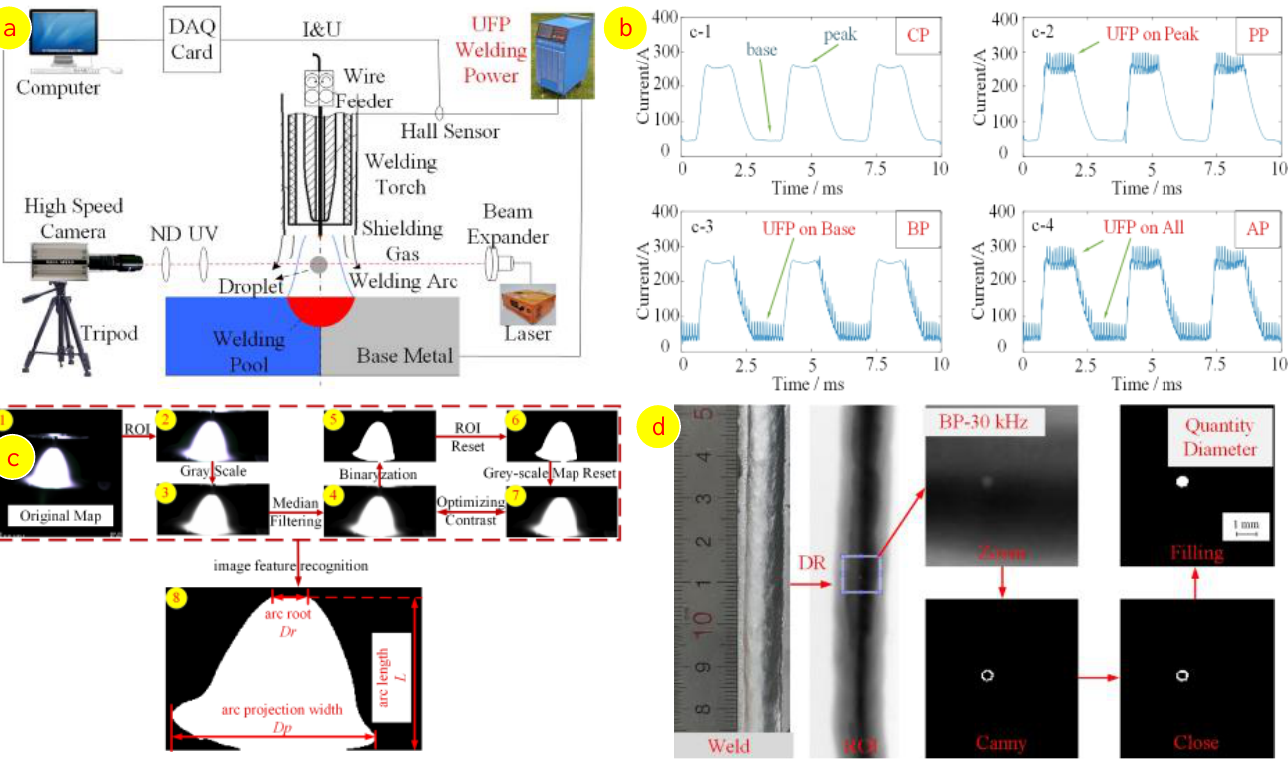
Figure 1. UFP-GMAW arc/droplet monitoring system ( a ), current waveforms ( b ), image pro- cessing method of the arc shape ( c ), and image processing method of the porosity ( d ).